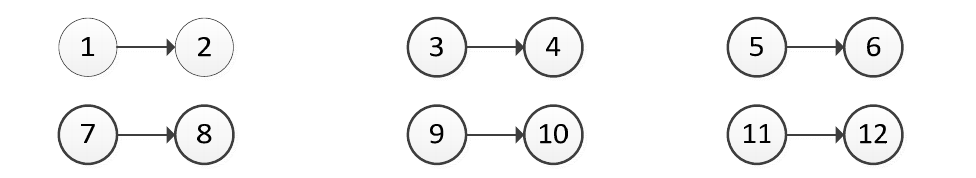
Figure 3. Graph Model of Changzhou Conflict for Movement by BPC.